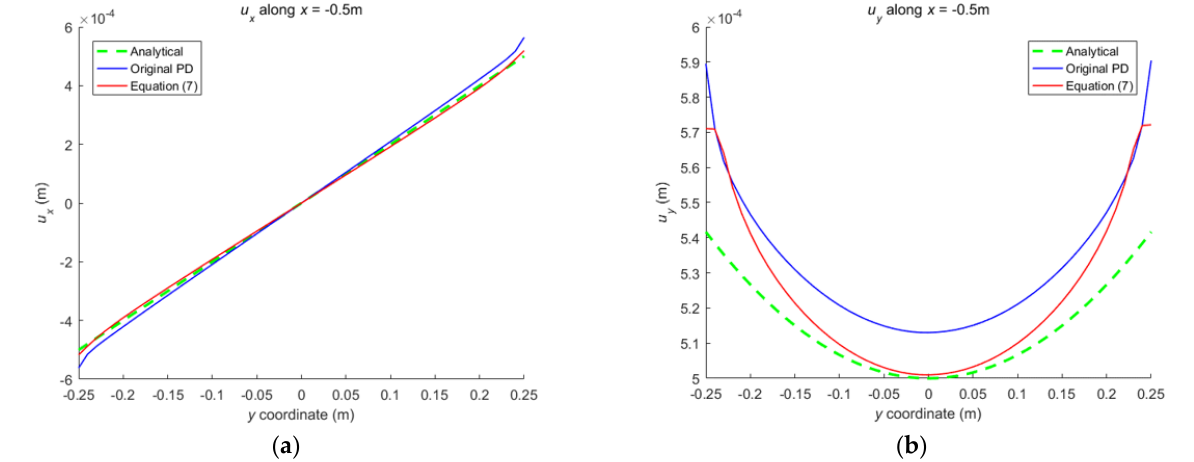
Figure 14. The displacement along the left side when the plate bending: ( a ) u x along x = − 0.5 m; ( b ) u y along x = − 0.5 m.